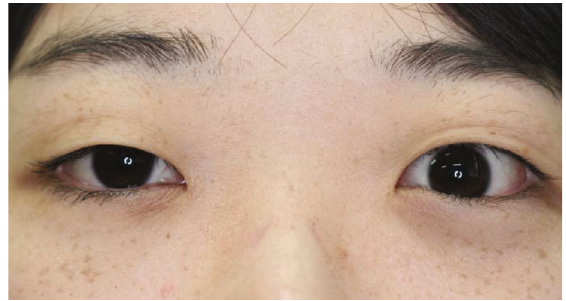
Figure 3: Clinical photograph of the patient at her last visit. Her eye position had